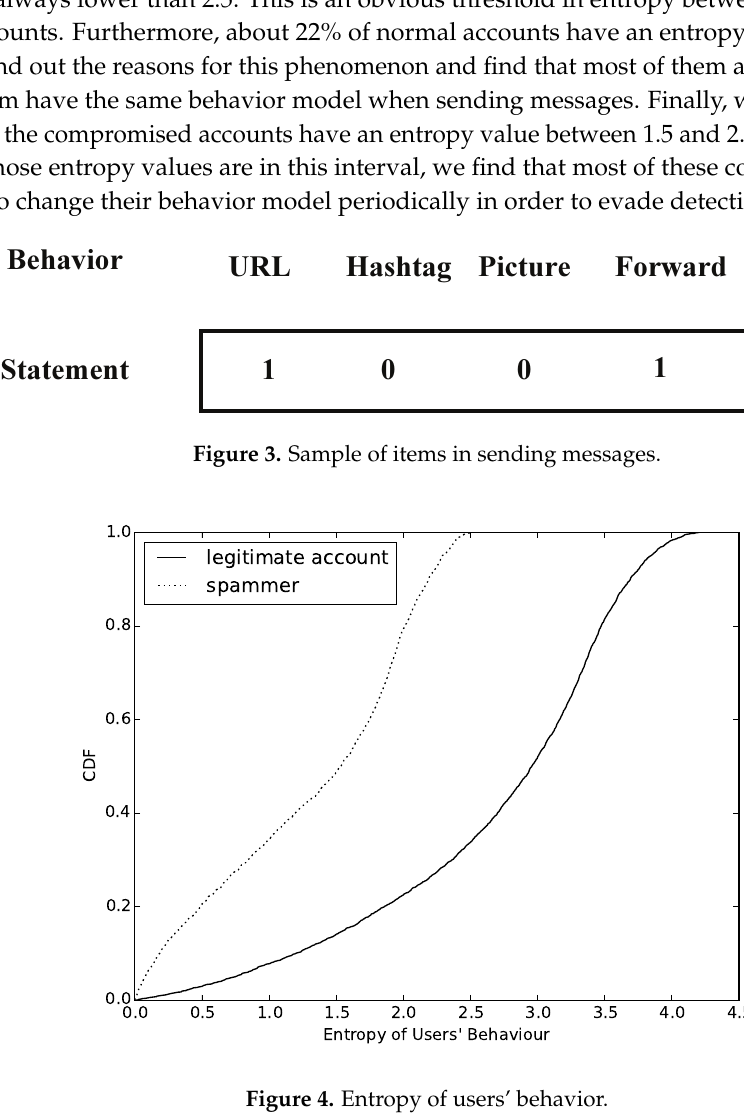
Figure 4. Entropy of users’